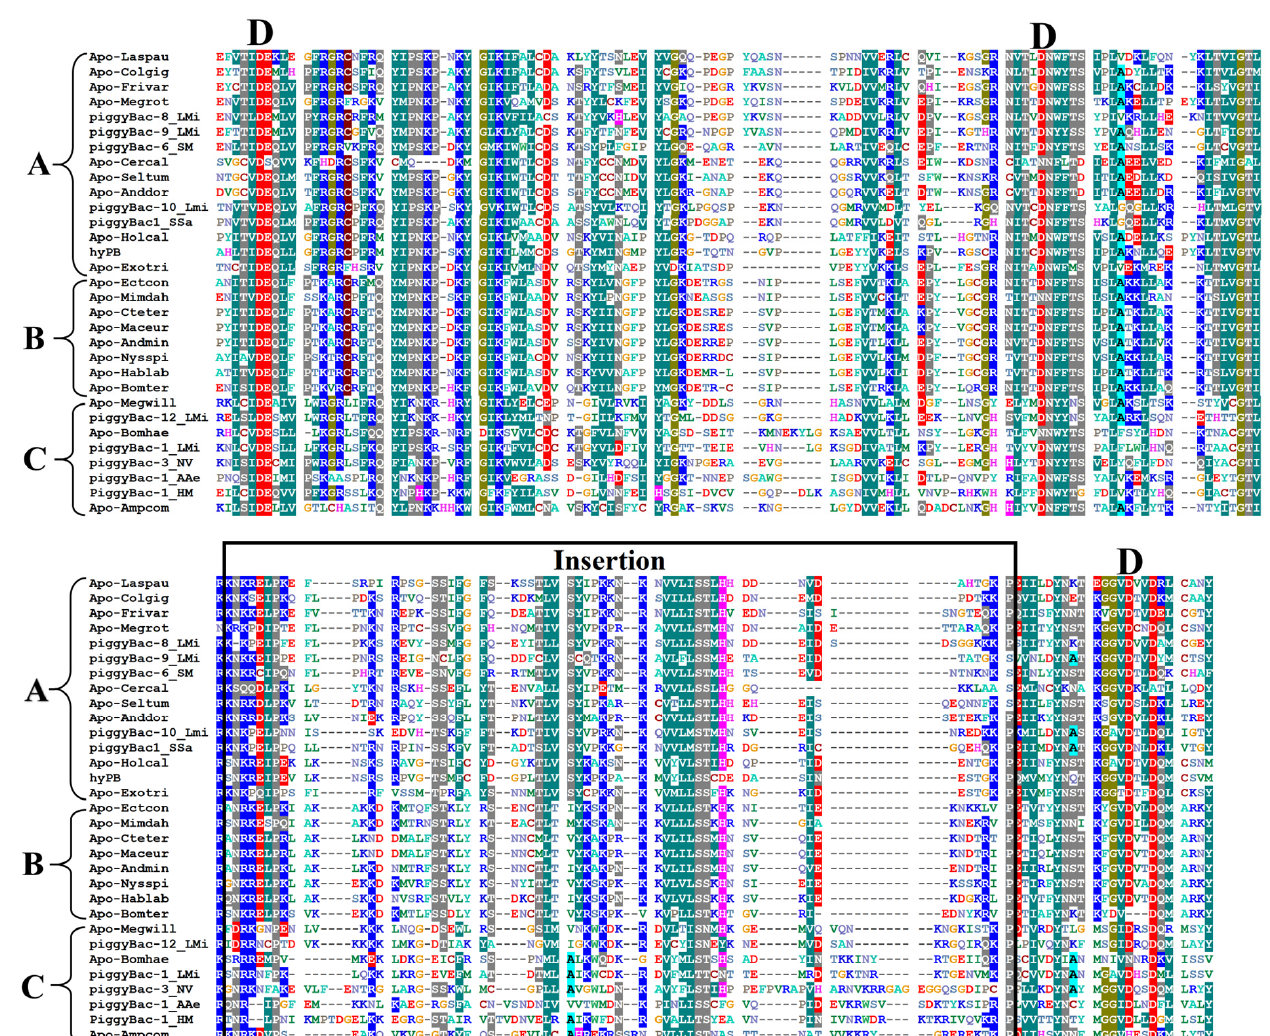
Figure 5. Multiple sequence alignments of the DDD domains of complete piggyBac ( PB ) transposases ( ≥ 500 aa) of three classes. The black frame represents the insertion motif of the DDD domain, and different conserved residues are colored differently. (Apo-Laspau: Lasioglossum pauxillum , Apo-Colgig: Colletes gigas , Apo-Frivar: Frieseomelitta varia , Apo-Megrot: Megachile rotundata , Apo-Cercal: Ceratina calcarata , Apo-Seltum: Seladonia tumulorum , Apo-Anddor: Andrena dorsata , Apo-Holcal: Holcopasites calliopsidis, Apo-Exotri: Exoneurella tridentata , Apo-Ectcon: Ectemnius continuus , Apo-Mimdah: Mimumesa dahlbomi , Apo-Cteter: Ctenoplectra terminalis , Apo-Maceur: Macropis europaea , Apo-Andmin: Andrena minutula , Apo-Nysspi: Nysson spinosus , Apo-Hablab: Habropoda laboriosa , Apo-Bomter: Bombus terrestris , Apo-Megwil: Megachile willughbiella , Apo-Bomhae: Bombus haemorrhoidalis , Apo-Ampcom: Ampulex compressa ). Multiple sequence alignments of other domains are in Supplementary Figure S2.